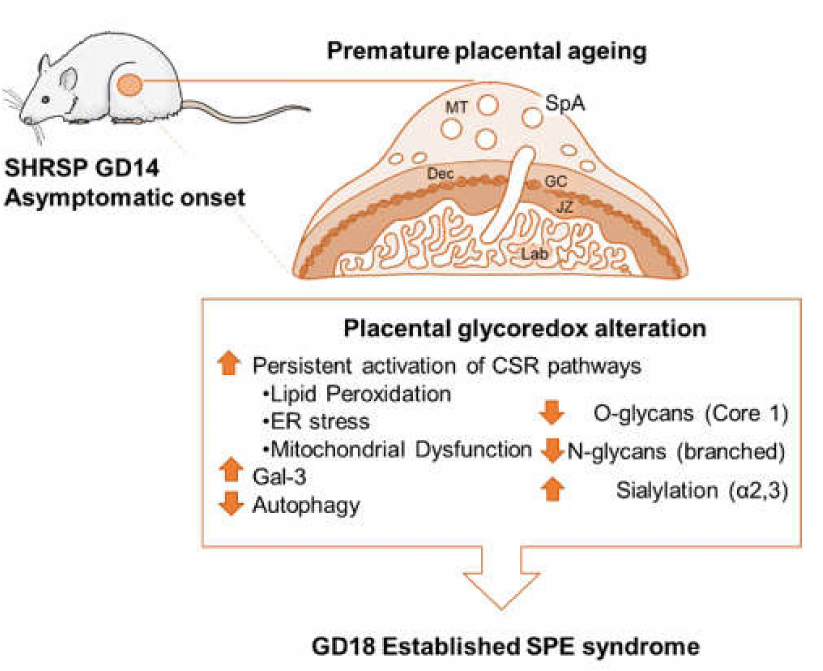
Figure 6. Summary of the placental molecular pathways involved in the pathogenesis of SPE in SHRSP pregnancies. Abbreviations: MT, mesometrial triangle; GC, giant cells; JZ, junctional